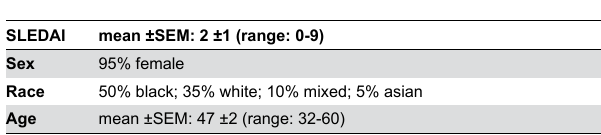
Table 1. Patient